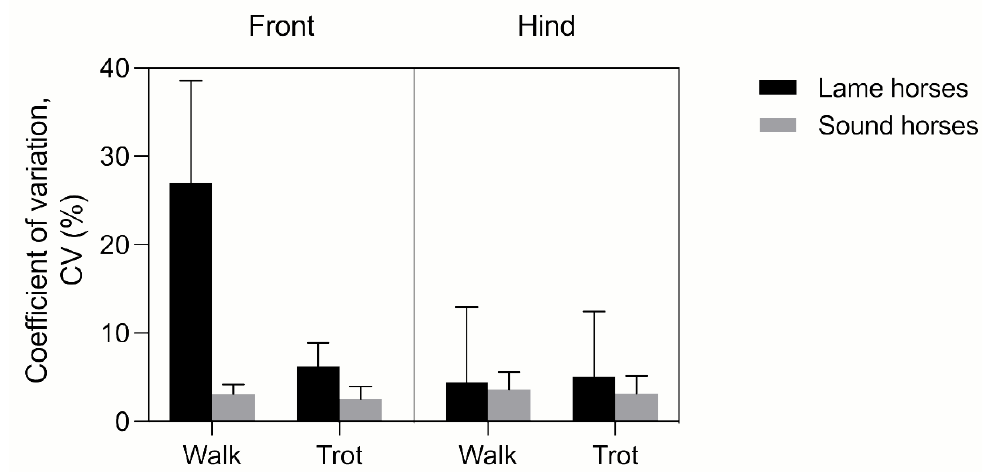
Figure 8. Effect of lameness, gait, and front vs. hindlimbs on CV between left and right limb of the horses in the study.